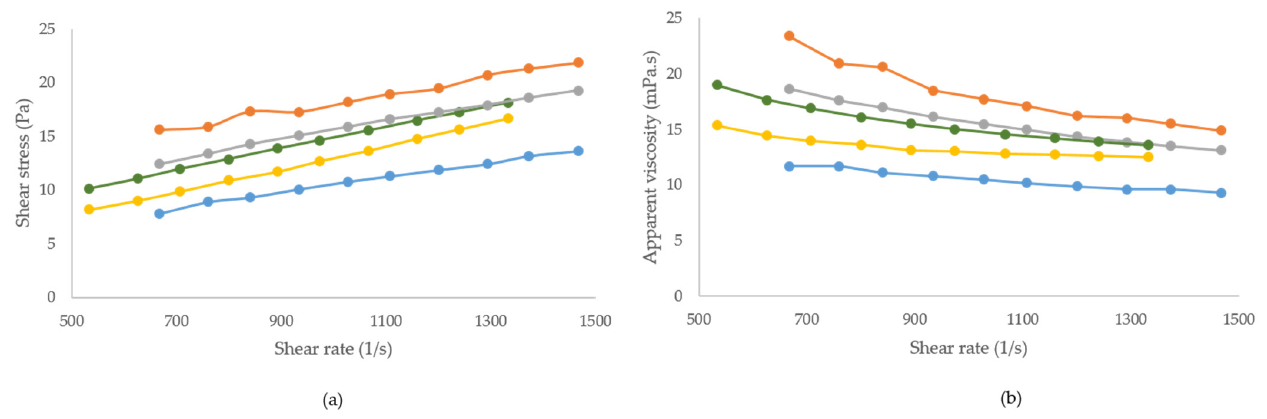
Figure 2. Rheological properties of edible coatings at different temperatures. ( a ) Flow curve; ( b ) apparent viscosity curve.